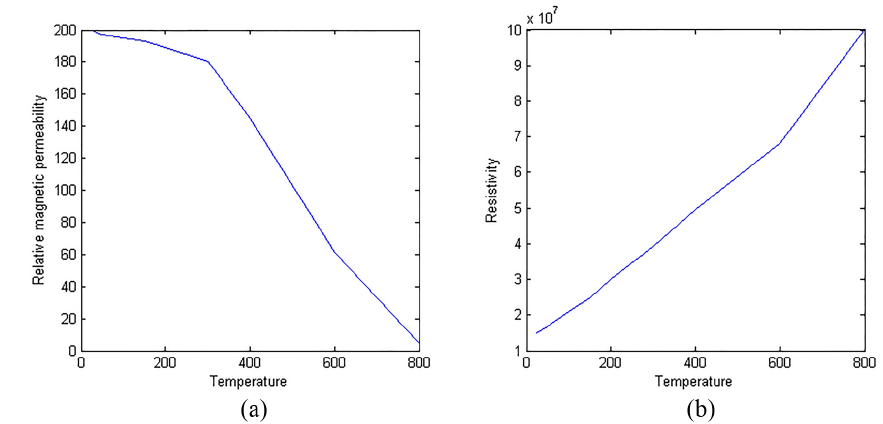
Figure 3. Electromagnetic parameters of brake disc changing with temperature curve.